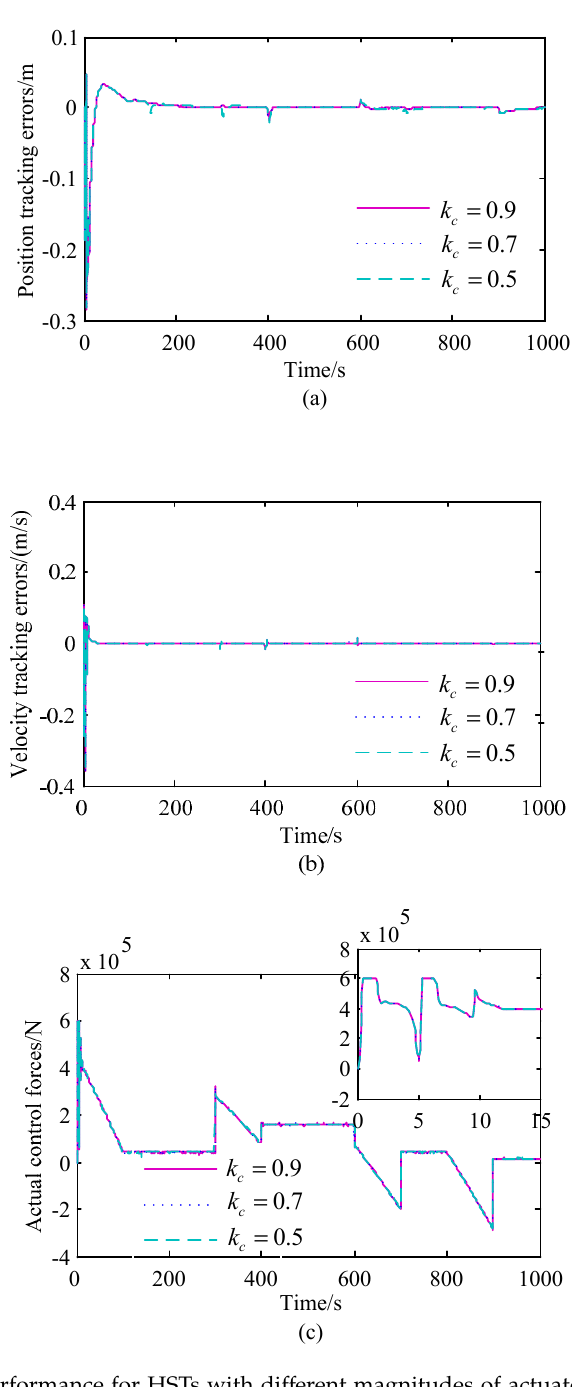
Figure 6. Control performance for HSTs with different magnitudes of actuator faults: ( a ) position tracking errors, ( b ) velocity tracking errors, ( c ) actual control forces.